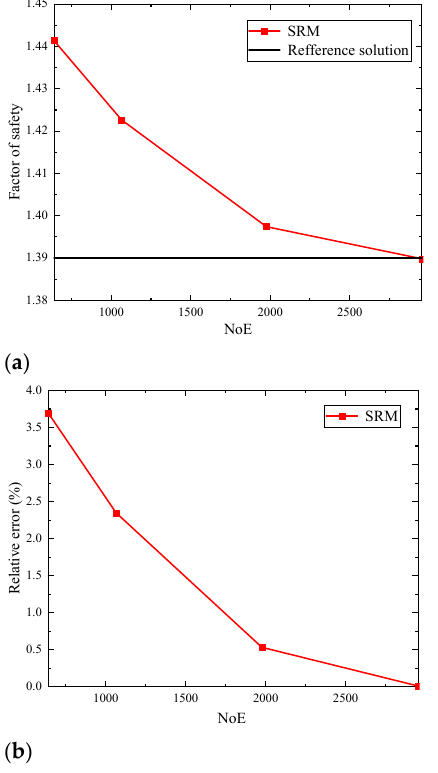
Figure 7. The convergence of the numerical solution. ( a ) Convergence for the factor of safety. ( b ) Convergence of relative errors for the factor of safety. The slope toe was defined as the coordinate origin, X -axis along the slope surface,